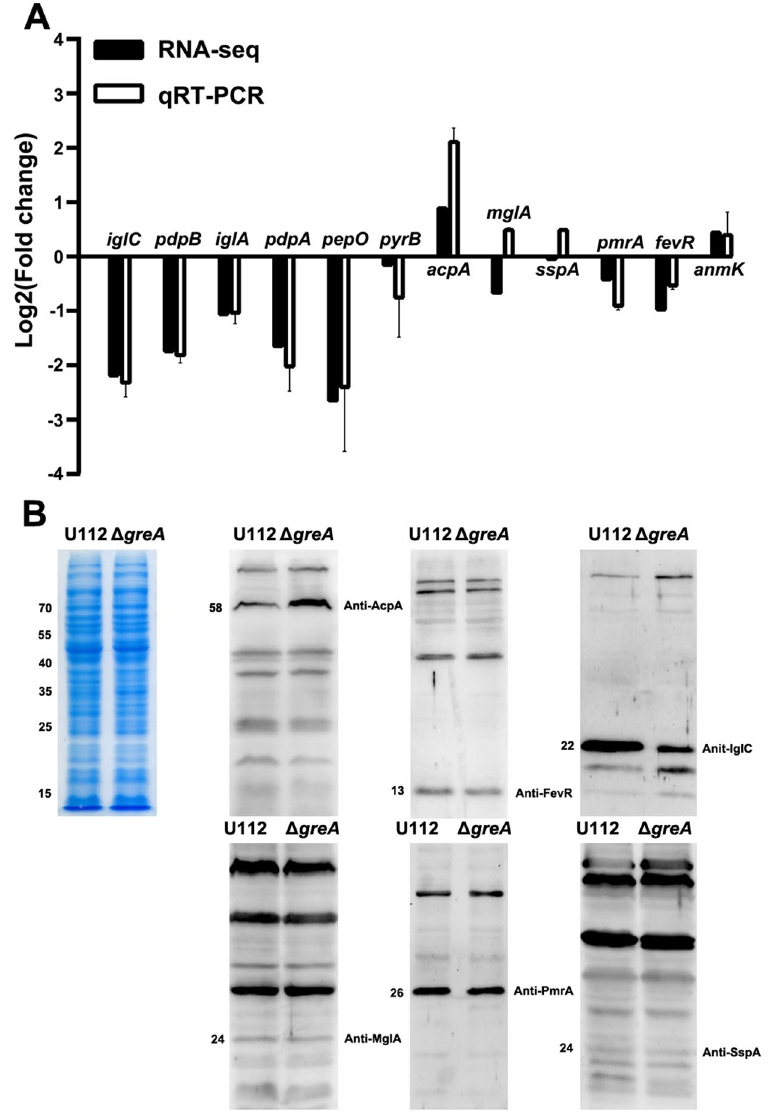
Figure 6. Verification of RNA-seq data. ( A ) Detection of gene transcription in the wild-type U112 strain and the Δ greA mutant. Transcription levels of genes by RNA-seq were shown with solid bars. Relative level of each target gene (open bars) by qRT-PCR was normalized to that of the 16S rRNA gene. Data are presented as mean fold changes relative to the wild-type U112 strain ± SD of the results from triplicate samples. The experiment was repeated twice. ( B ) Detection of protein expression in the wild-type U112 strain and the Δ greA mutant. Mid-log bacteria were resuspended in PBS to OD 600 = 1.0. The suspensions were concentrated 10-fold, separated with SDS-PAGE, and detected with western blotting, using antiserum specific for each target protein. The left panel is a section of a coomassie stained gel as a loading control. The coomassie stained gel image was acquired with the digital camera (Canon, Janpan). The experiment was repeated twice. Size of each protein is indicated on the left in